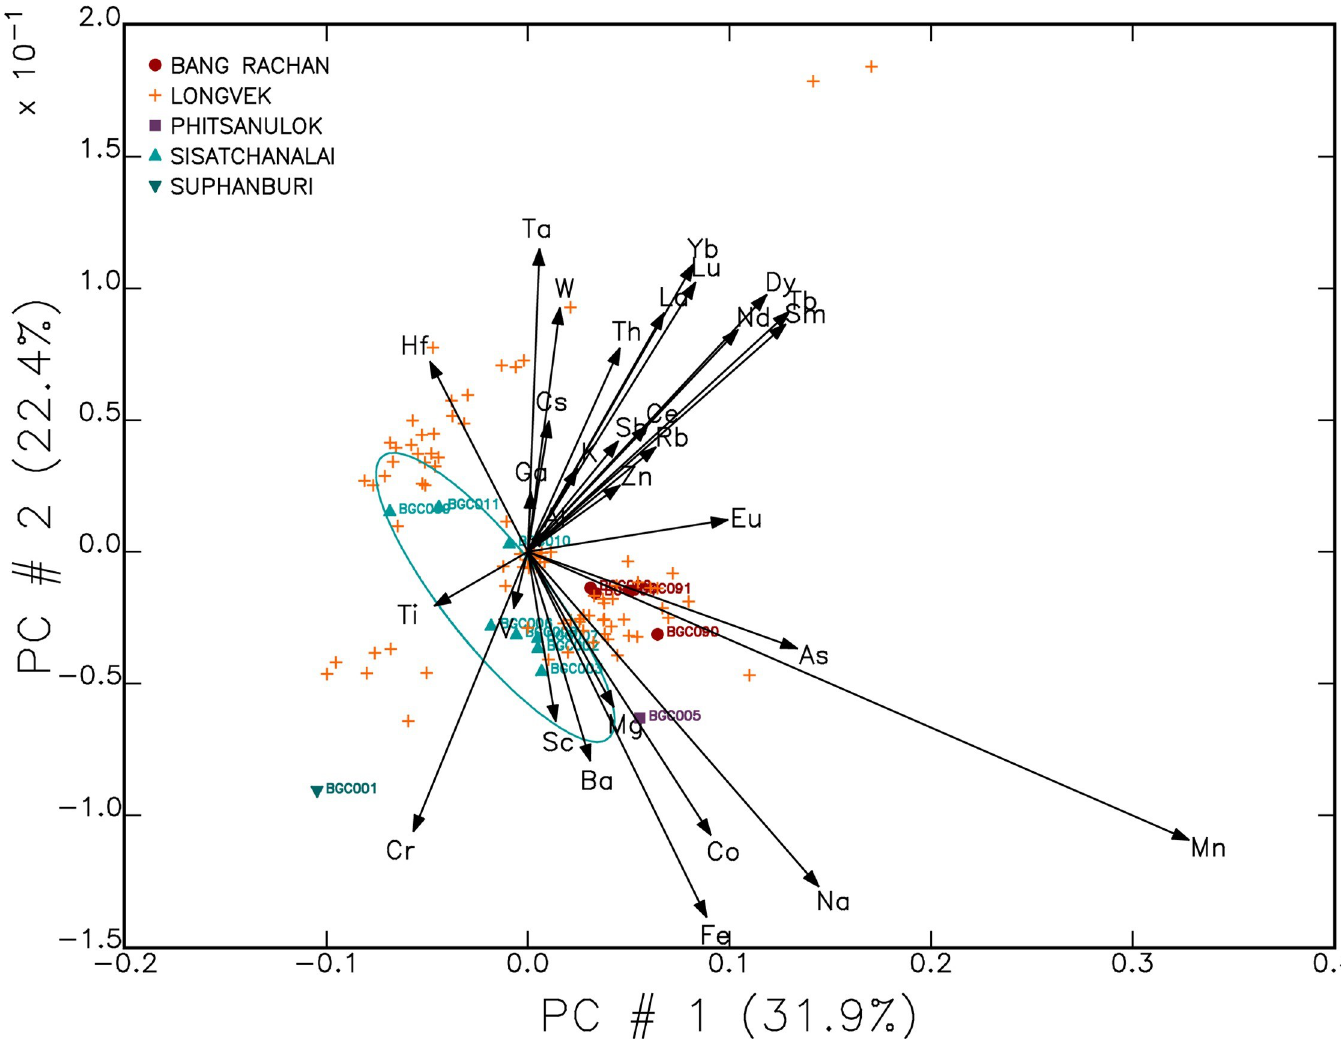
Fig 4. Biplot of first two principal components, describing 54.85% of data set cumulative variation.